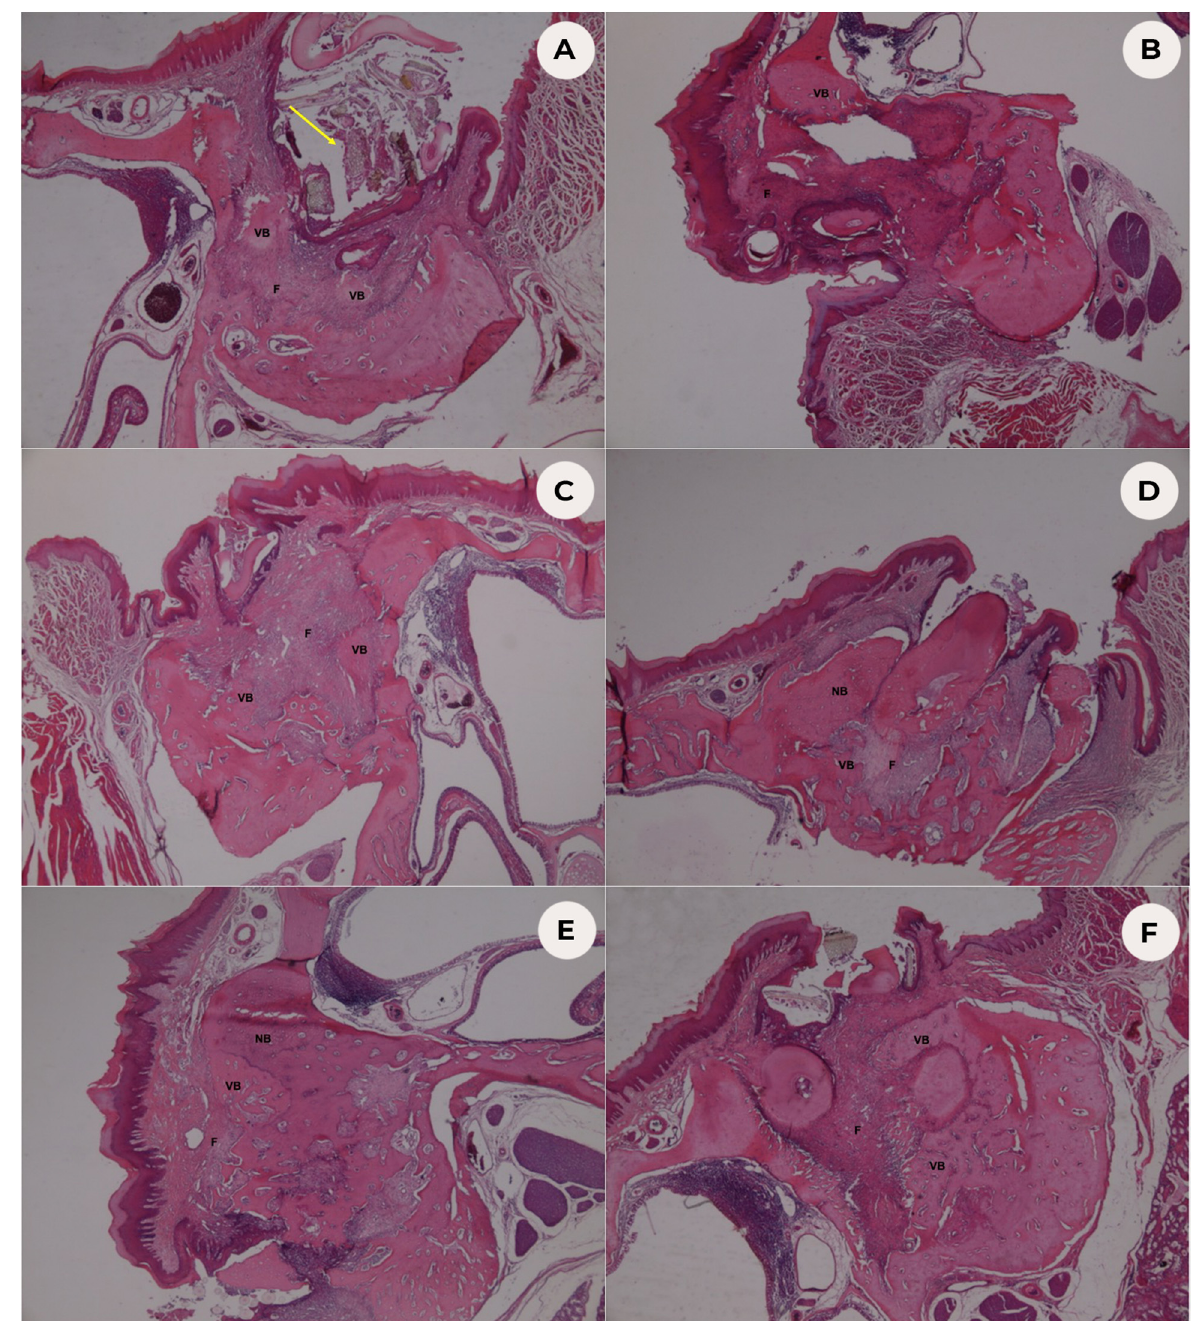
Figure 1. ( A ) Histological image of Group I (Control): new bone formation and fibrosis were observed in the extraction socket under the epithelium on which food residues accumulated (arrow). VB: Vital Bone; F: Fibrosis. ( B ) Histological image of Group II (GS): new bone formation, fibrosis, and mild inflammation were seen in the extraction socket. VB: Vital Bone; F: Fibrosis. ( C ) Histological image of Group III (GS/DFO): new bone formation and fibrosis filled the extraction socket. VB: Vital Bone; F, Fibrosis. ( D ) Histological image of Group IV (ZA): failure in healing of the bone and necrotic bone in the extraction socket. NB: Necrotic Bone; VB: Vital Bone; F: Fibrosis. ( E ) Histological image of Group V (ZA-GS): a small necrotic portion of the alveolar bone surrounding the extraction socket. NB: Necrotic Bone; VB: Vital Bone; F: Fibrosis. ( F ) Histological image of Group VI (ZA-GS/DFO): new bone formation and fibrosis were detected in the extraction socket. VB: Vital Bone; F: Fibrosis. (Hematoxylin & Eosin, Original magnification ×40).